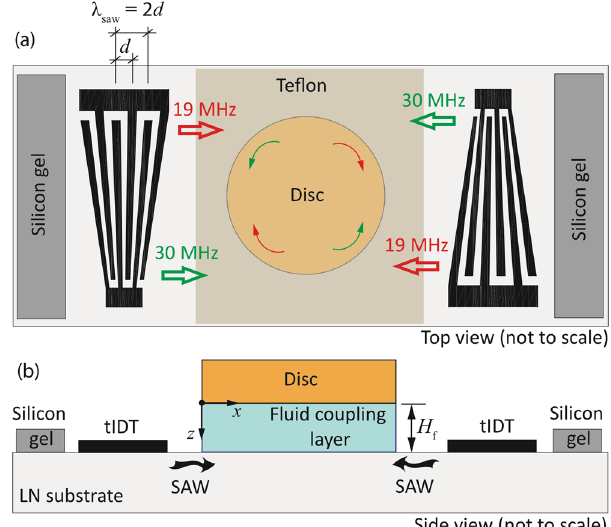
Figure 2. ( a ) Top, and, ( b ) side view schematics depicting the setup used in the present experiments, which comprises a pair of tapered interdigital transducers (tIDTs) patterned on the piezoelectric lithium niobate (LN) substrate. A thin disc is placed atop a fluid coupling layer which the SAW is transmitted into to drive acoustic streaming in a small strip aligned with the position where the SAW is launched, depending on the choice of the operating frequency. For the case of the tIDT design in this work, this is in the range 19–30 MHz. As illustrated, excitation of the tIDTs at a resonant frequency of 19 MHz launches a narrow width SAW at the top left and bottom right in the top view image in ( a ) so as to drive clockwise rotation of the fluid and hence the disc. Similarly, excitation of the tIDTs at 30 MHz launches the SAW at the bottom left and top right in ( a ) so as to drive counter-clockwise